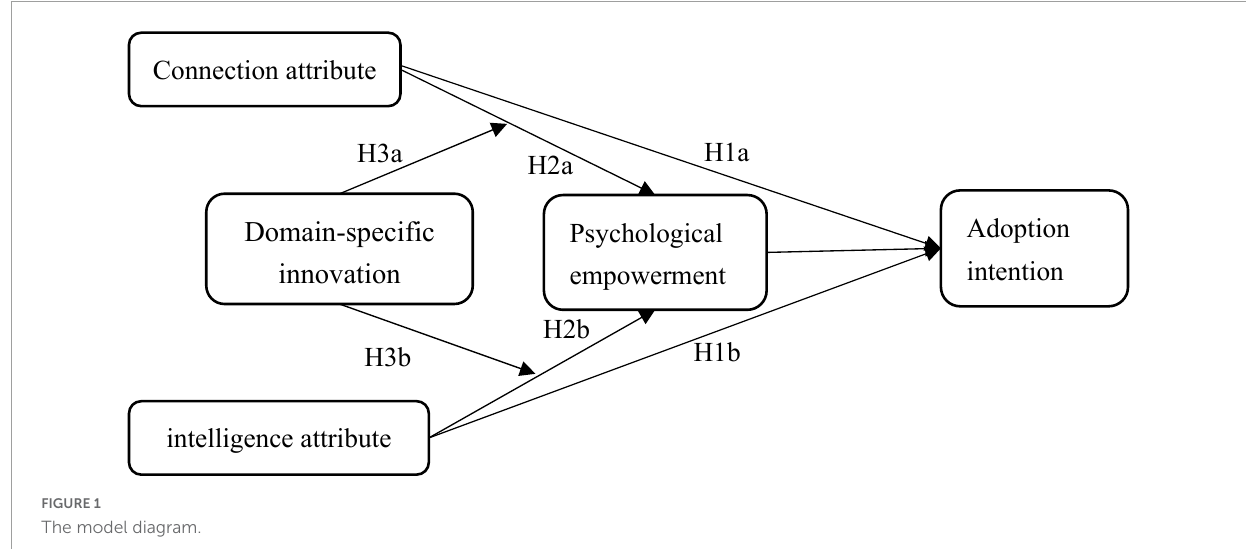
FIGURE1 The model diagram.